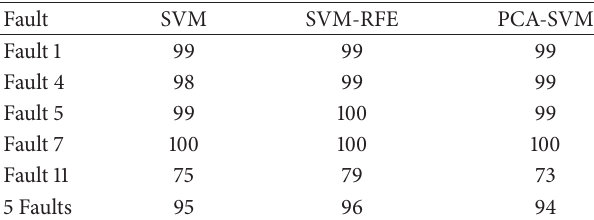
Table 3: TE process: fault detection rate for testing data. Fault